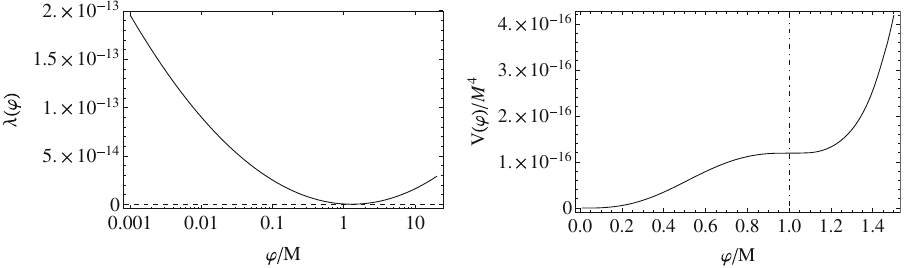
Fig. 1 The left panel shows the RG running of inflaton quartic cou- pling as a function of ϕ/ M . We have fixed M = M P , so that g ( M ) = 1 . 6 × 10 − 3 , Y ( M ) (cid:2) 1 . 0 × 10 − 2 , and λ( M ) (cid:2) 4 . 8 × 10 − 16 . Dashed